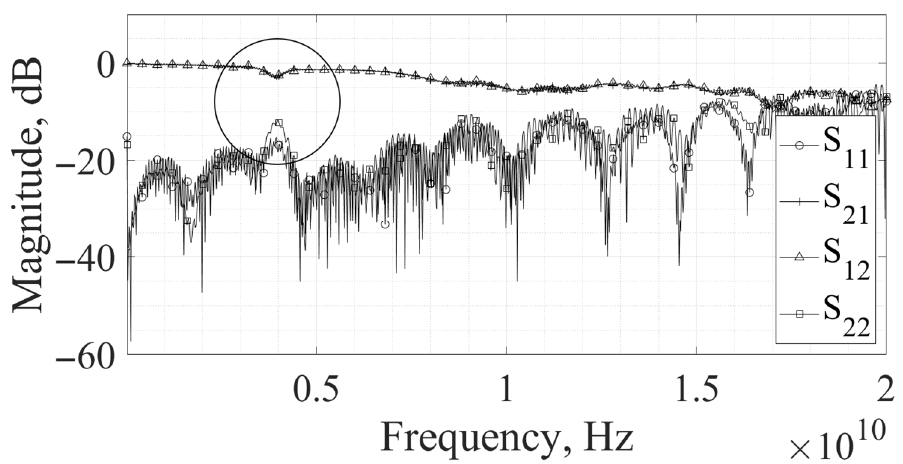
Figure 2. S parameters of MSL with poorly twisted connectors. The circle highlights symmetry violations of reflection coefficients and transmission coefficients.